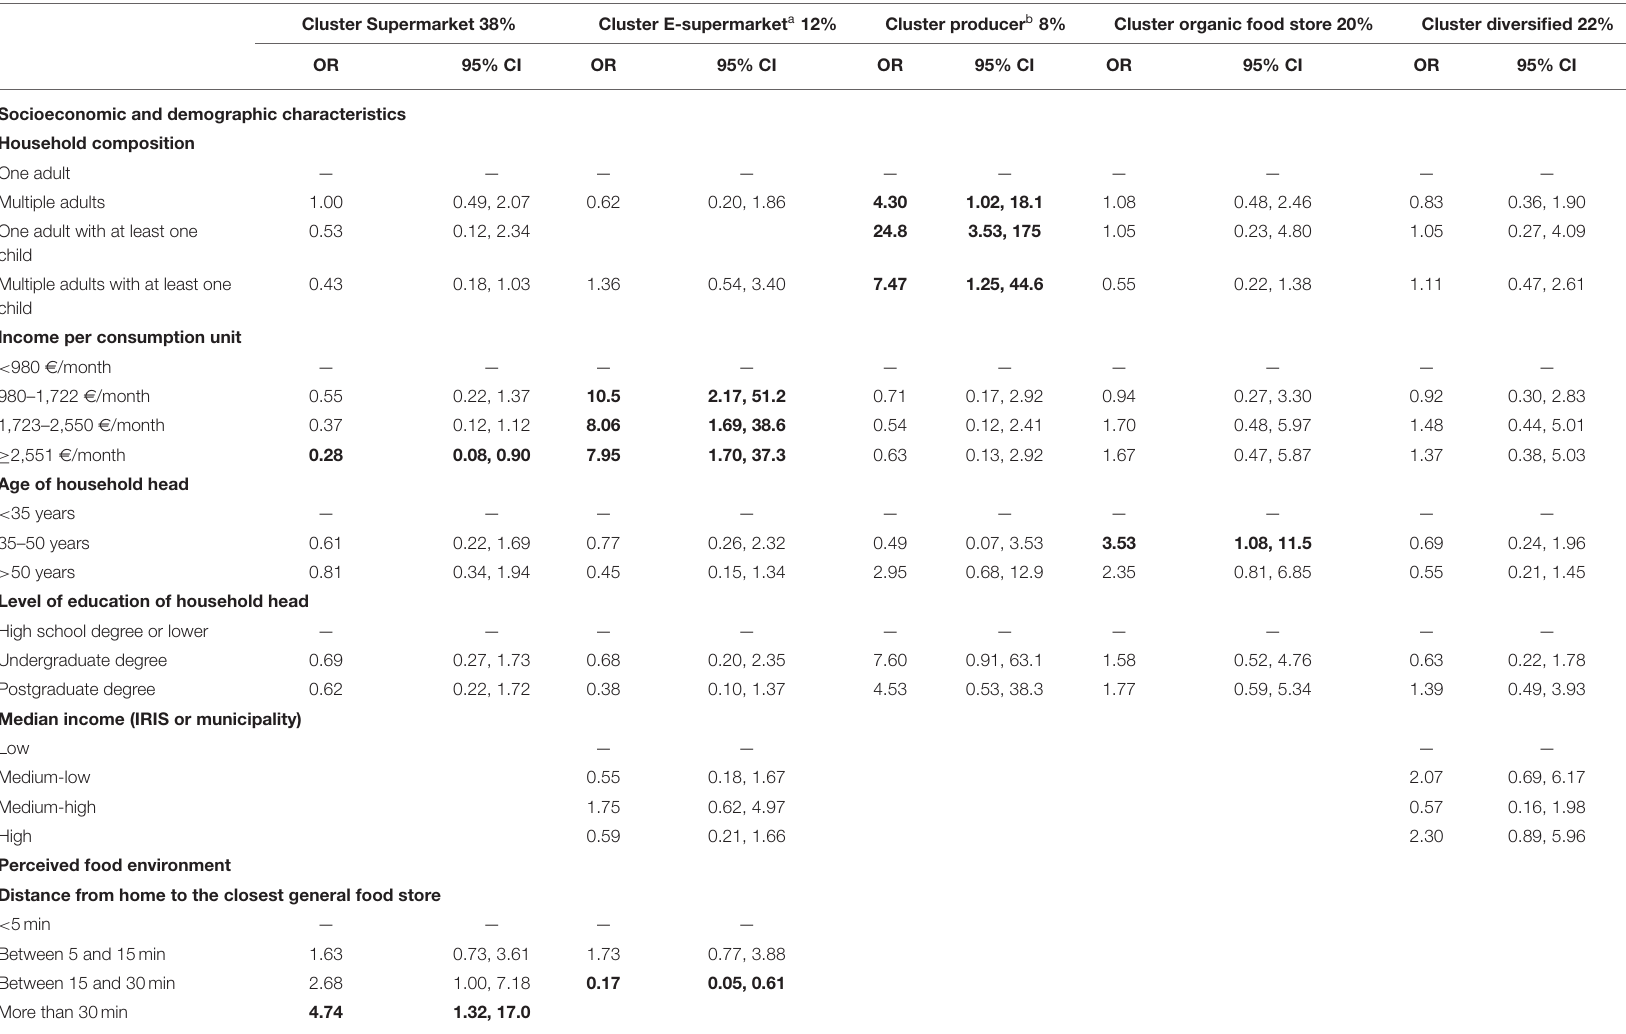
TABLE 3 | Associations between clusters and socioeconomic and demographic characteristics, perceived, and objective FE